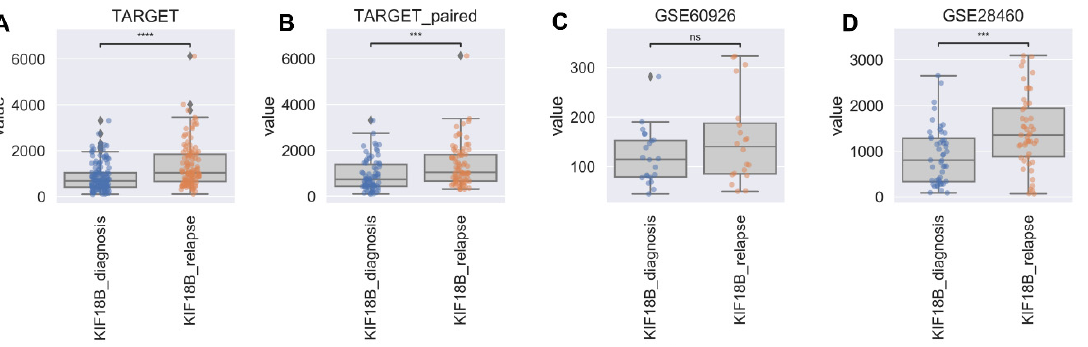
Figure 2. Di ff erences in Expression Levels of KIF18B in B cell acute lymphoblastic leukemia (ALL). Comparison of KIF18B expression levels in ( A ) TARGET, ( B ) TARGET_paired sample, ( C ) GSE60926 and ( D ) GSE28460 (**** indicates significance at p value < 0.0001, *** indicates significance at p value < 0.001, ns means that there is no significant difference).